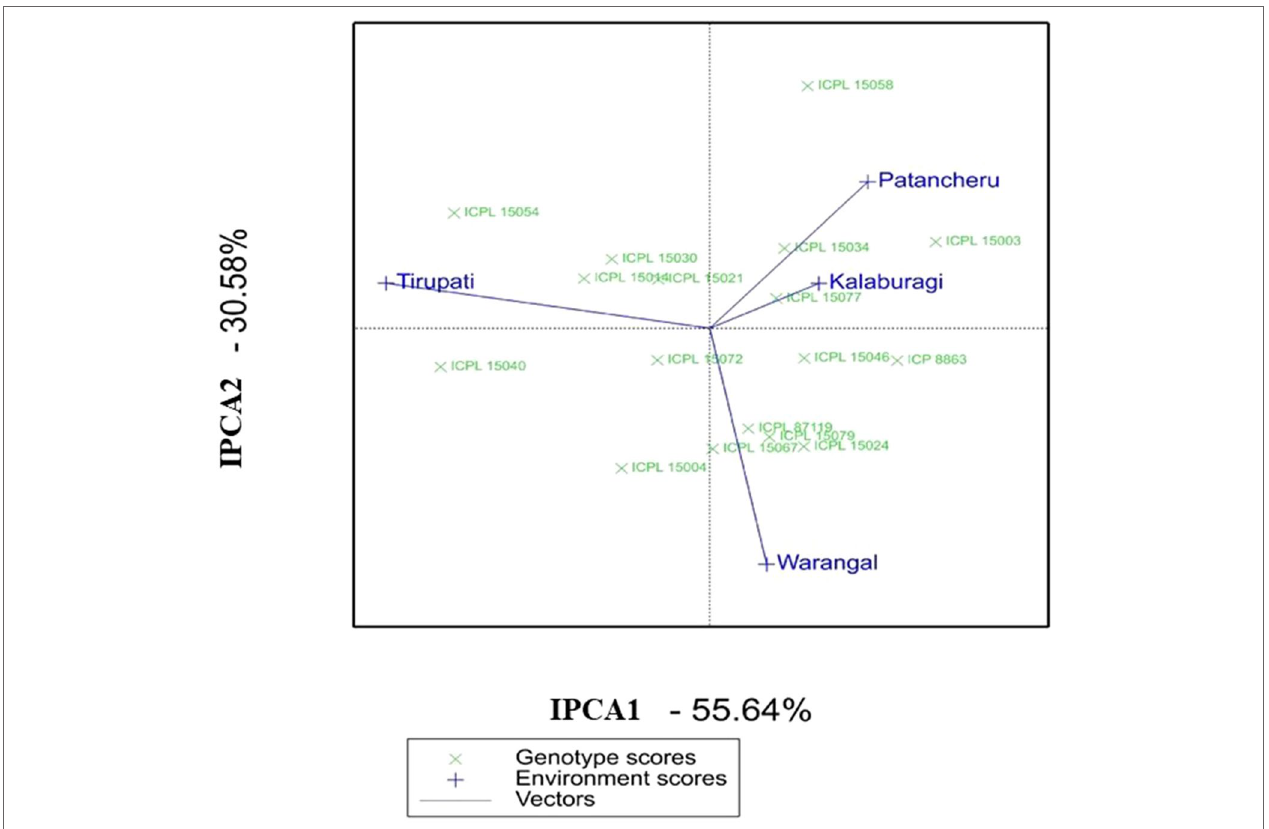
FIGURE 2 | Additive main effects and multiplicative interaction (AMMI) biplot showing the first two principal axes of interaction (IPCA1 vs IPCA2) for the grain yield per plant of 15 introgression lines in MET 02 across four locations during the 2016 rainy season in